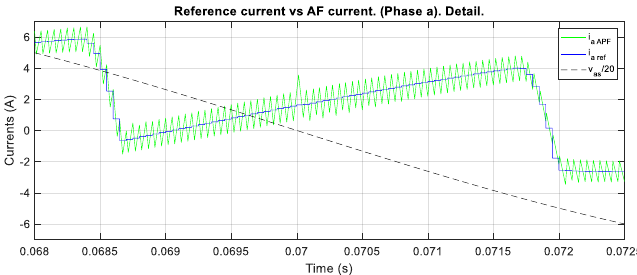
Figure 12. Current tracking performance for phase a . Detail 2 (0.068 s < t < 0.0725 s).